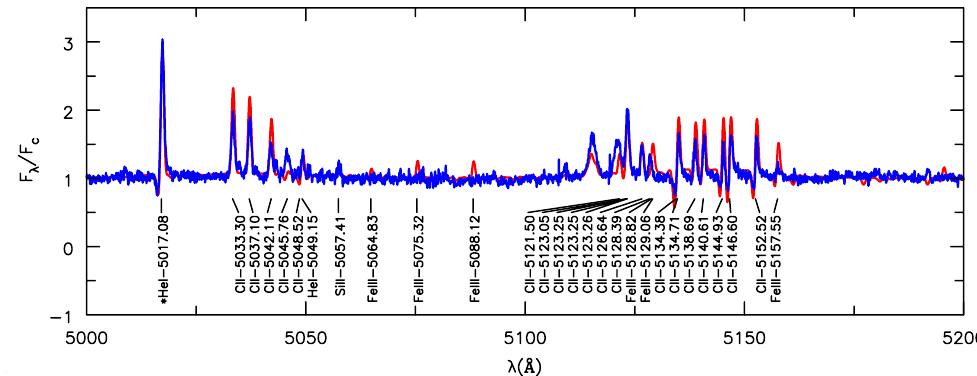
Figure 14. A small section of the spectrum of the WC 11 star J0608 (blue) which was obtained by Nidia Morrell (private communication). A model fit (in red) is shown and model lines are identified. The broad feature near 5115Å (the first unidentified feature) is due to a resonance in the C II free–free (i.e., Bremsstrahlung) cross-section. It arises from the 2s 2p( 3 P o )3d 2 P o − 2s2p( 3 P o )4f 2 D transition [117–119]. Both these states are